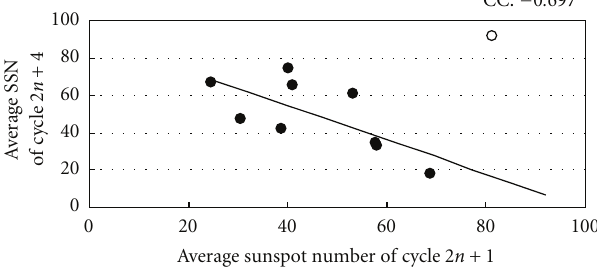
Figure 9: Scatter plot between the average sunspot number of odd-numbered cycles (abscissa) and that of the succeeding even- numbered cycle after the next cycle (ordinate), demonstrating an inverse relationship between the average sunspot number for (2 n + 4) cycles and that for (2 n +1) cycles. An outlier indicated by a white circle is omitted when the least-regression line is